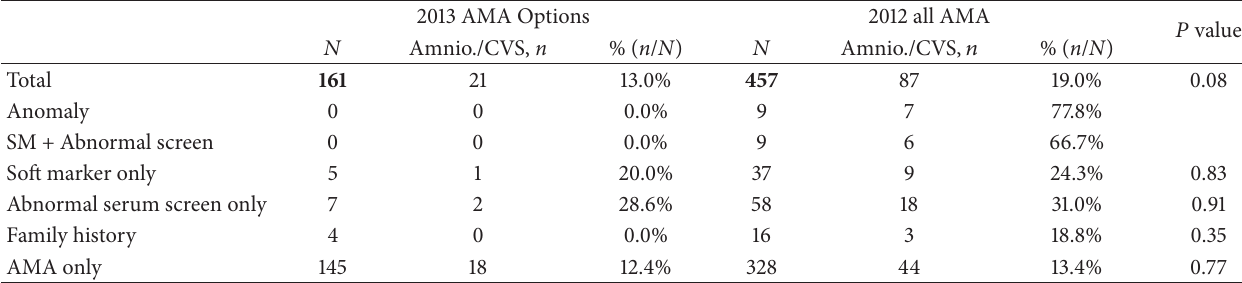
Table 1: Amniocentesis utilization and reason: 2013 AMA Options verses 2012 all AMA.